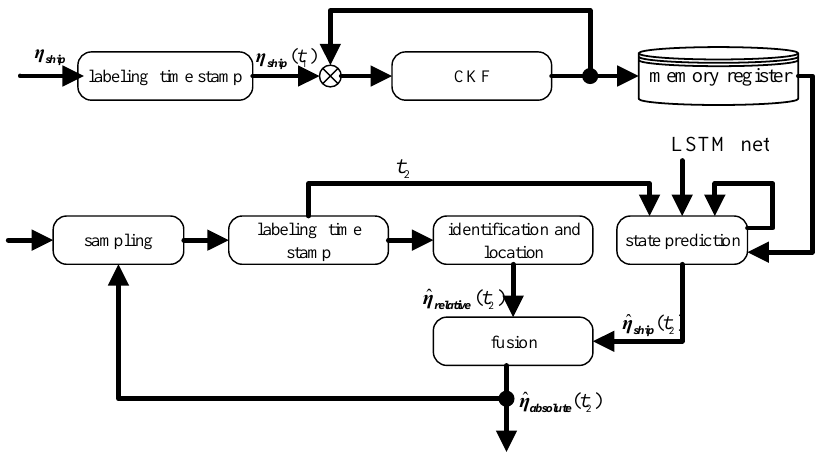
Figure 2. The algorithm flowchart of